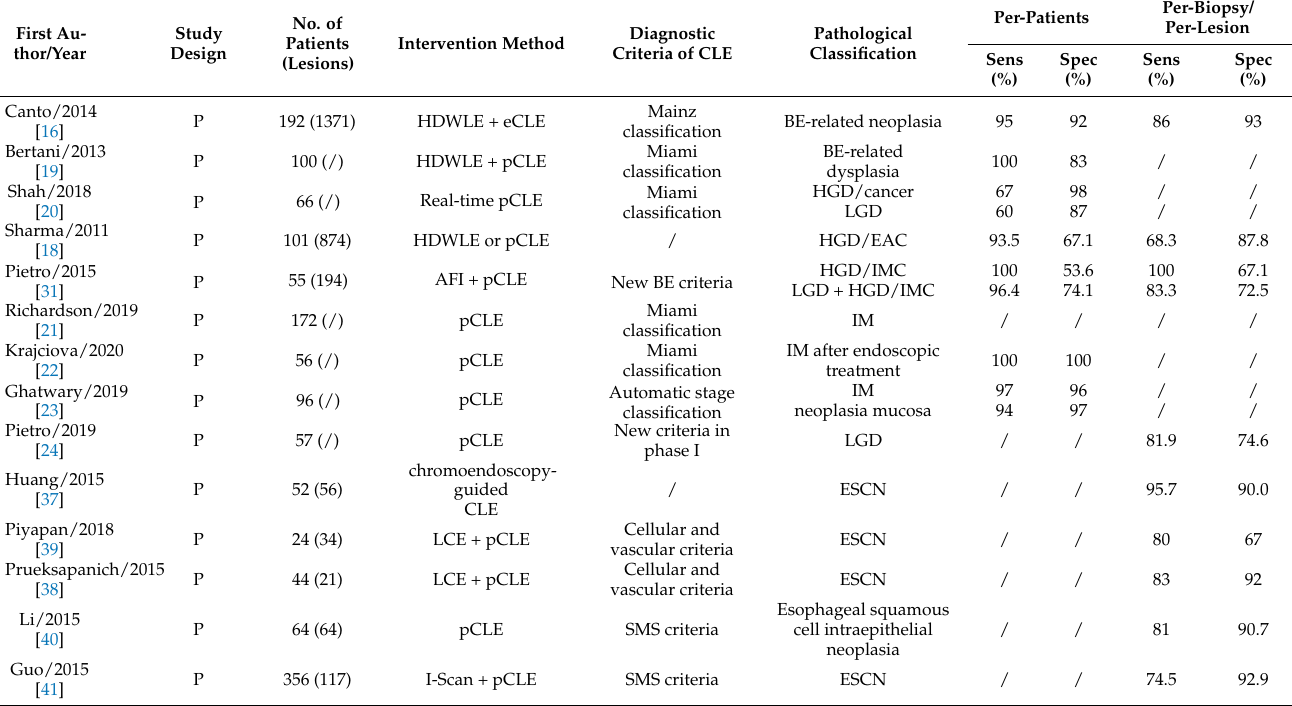
Table 2. Diagnostic value of CLE in the